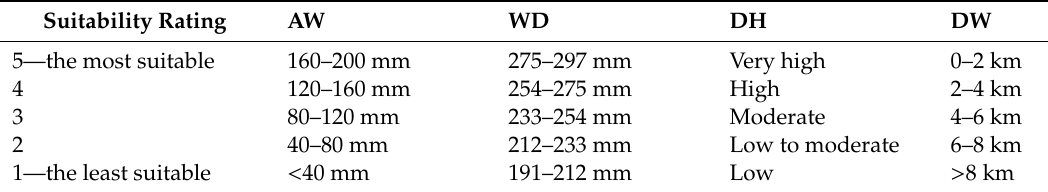
Table 4. The four criteria with five classes and corresponding suitability ratings.